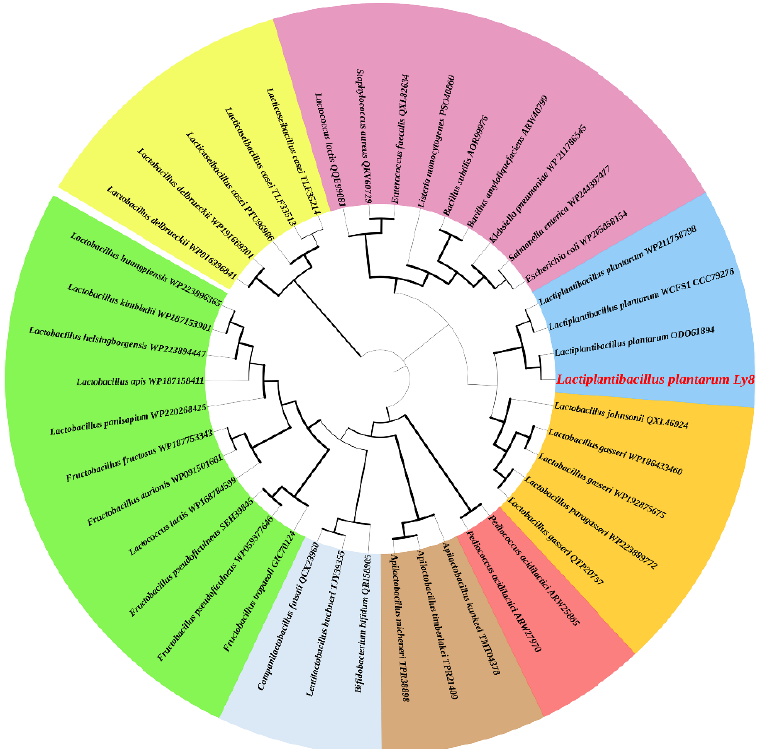
Figure 2. A phylogenetic maximum likelihood tree showing the relationships between ALDC from L. plantarum Ly8 and other bacterial ALDC proteins. The thickness of the branches indicates the percentages at which the given branches were supported with 1000 bootstrap replications. The GenBank accession numbers are displayed after the species name. L. plantarum Ly8 is marked with red font.